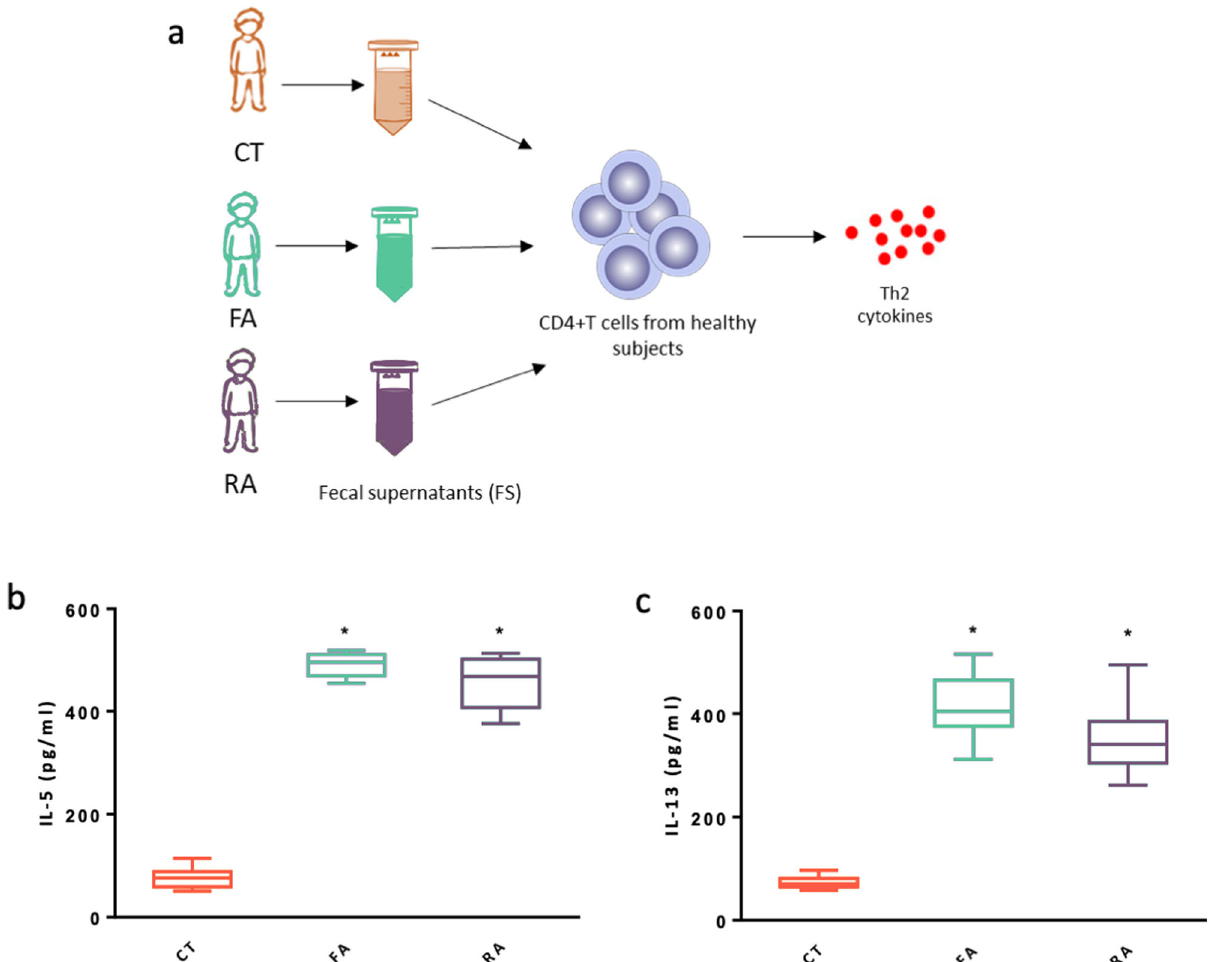
peripheral blood CD4 + T cells from healthy children ( n = 3) were exposed to fecal supernatants obtained from fecal samples collected from CT, FA and RA subjects ( n = 3/group) ( a ). Stimulation for 24 h with 100 µ l (optimal dose) of fecal supernantants obtained from FA and RA patients, but not with fecal supernatants from CT, induced a signi fi cant increase in IL-5 ( b ) and IL-13 ( c ) production by CD4 + T cells. Each fecal supernatant was tested in triplicate on three different peripheral blood CD4 + T cells samples. Data are expressed as mean ± standard deviation. * p = 0.0001, as de fi ned by paired t-test comparing CT vs FA and CT vs RA. ( a ) was generated using GraphPad Prism v.